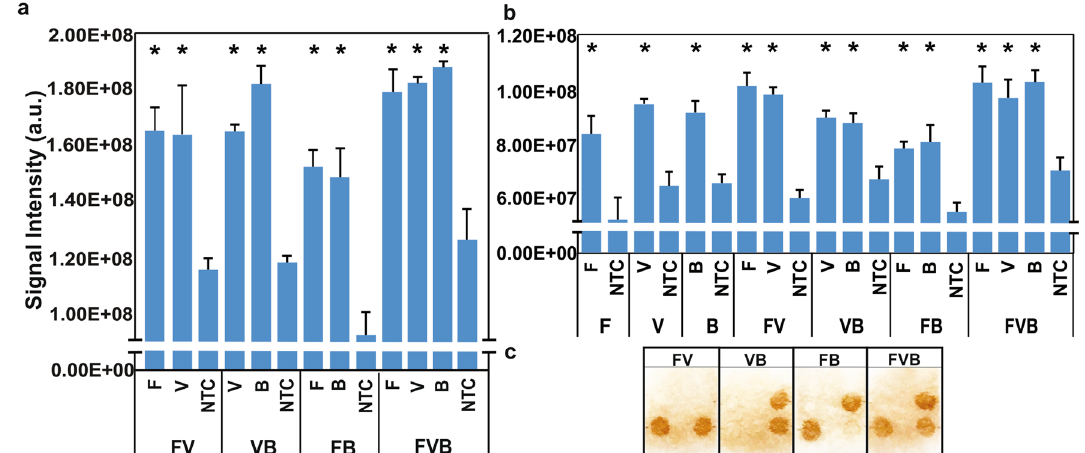
Figure 3. Detection with different types of targets. ( a ) Signal intensities of multiplex PCR products (FV, VB, FB, and FVB) amplified from genomic DNA. ( b ) Signal intensities from a single PCR product (F, V, and B) to a mixture of two or three single PCR products (FV, VB, FB, or FVB) amplified from spiked DNA. ( c ) Visual detection using multiplex PCR products amplified from spiked DNA. All the differences of intensities between the specific and the NTC signals on the same filter paper were significant. X axes of 3a and 3b represent the targets of detection. Y axes display the signal intensities. F: Saccharomyces cerevisiae . V: human cytomegalovirus.